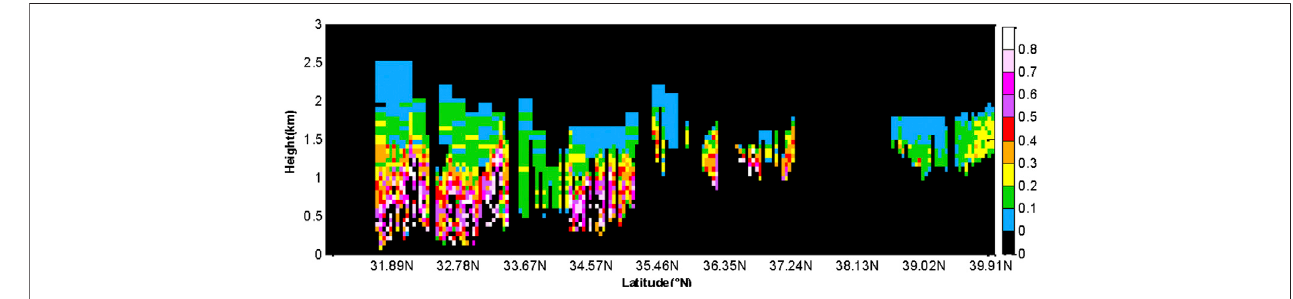
FIGURE 7 | Vertical distribution of the aerosol extinction coef fi cients along the CALIPSO orbit at 13:00 January 16.